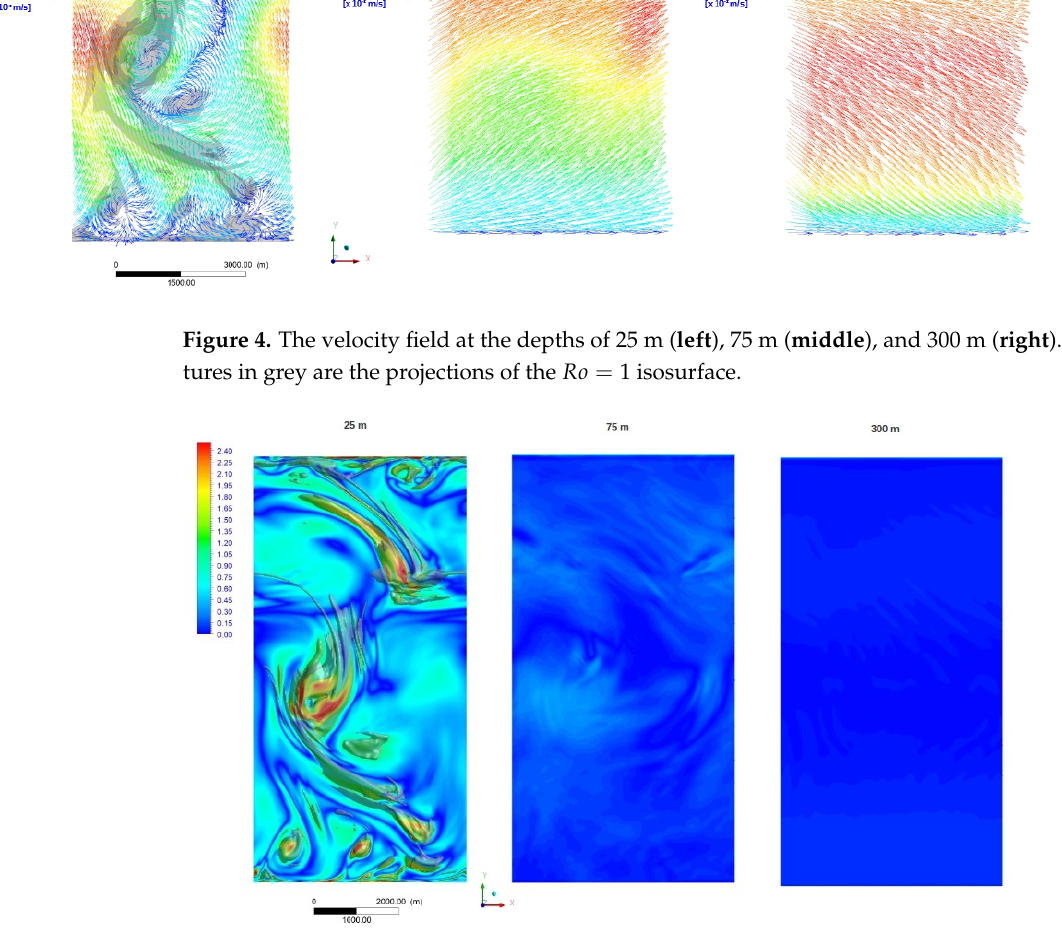
Figure 5. The Rossby number distribution at the depths of 25 m ( left ), 75 m ( middle ), and 300 m ( right